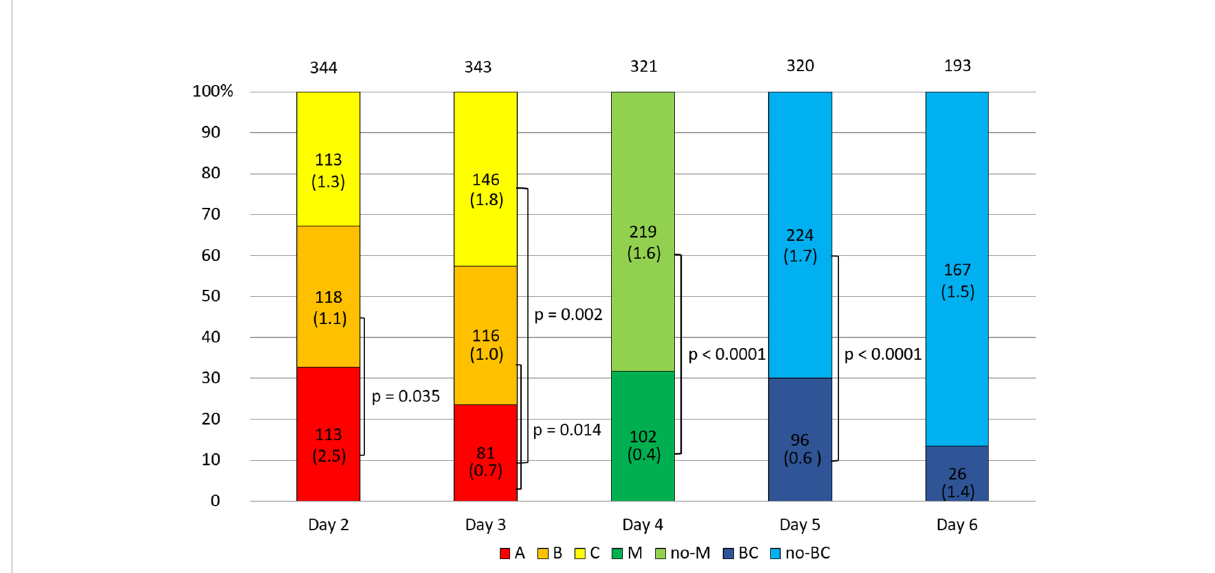
FIGURE 1 Quality of the embryos depending on the day of development. 1) development of embryos over time from the second to the sixth day (height of the colored stripes); 2) comparisons of secretion between embryos of different classes or stages of development (vertical clamps). A, B, C – class of the embryo; M – embryo in the morula stage; no-M – embryo that has not reached the morula stage; BC – embryo in the blastocyst stage; no-BC – embryo that has not reached the blastocyst stage. Median concentration of sHLA-G was presented in brackets. P-values are calculated by Mann-Whitney